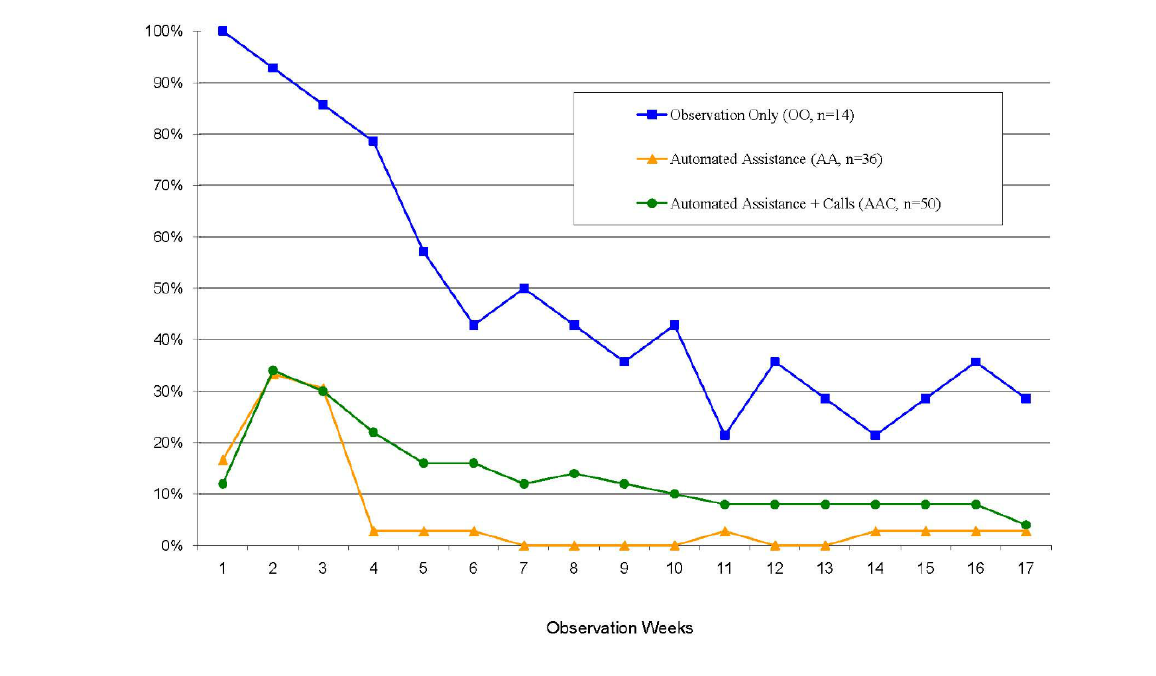
Figure 2. Percentage of participants, by group, self-monitoring 1 or more times per week (N = 100). The prompting intervention occurred during weeks 2 and 3. AA = automated assistance group, AAC = automated assistance + calls group, OO = observation-only